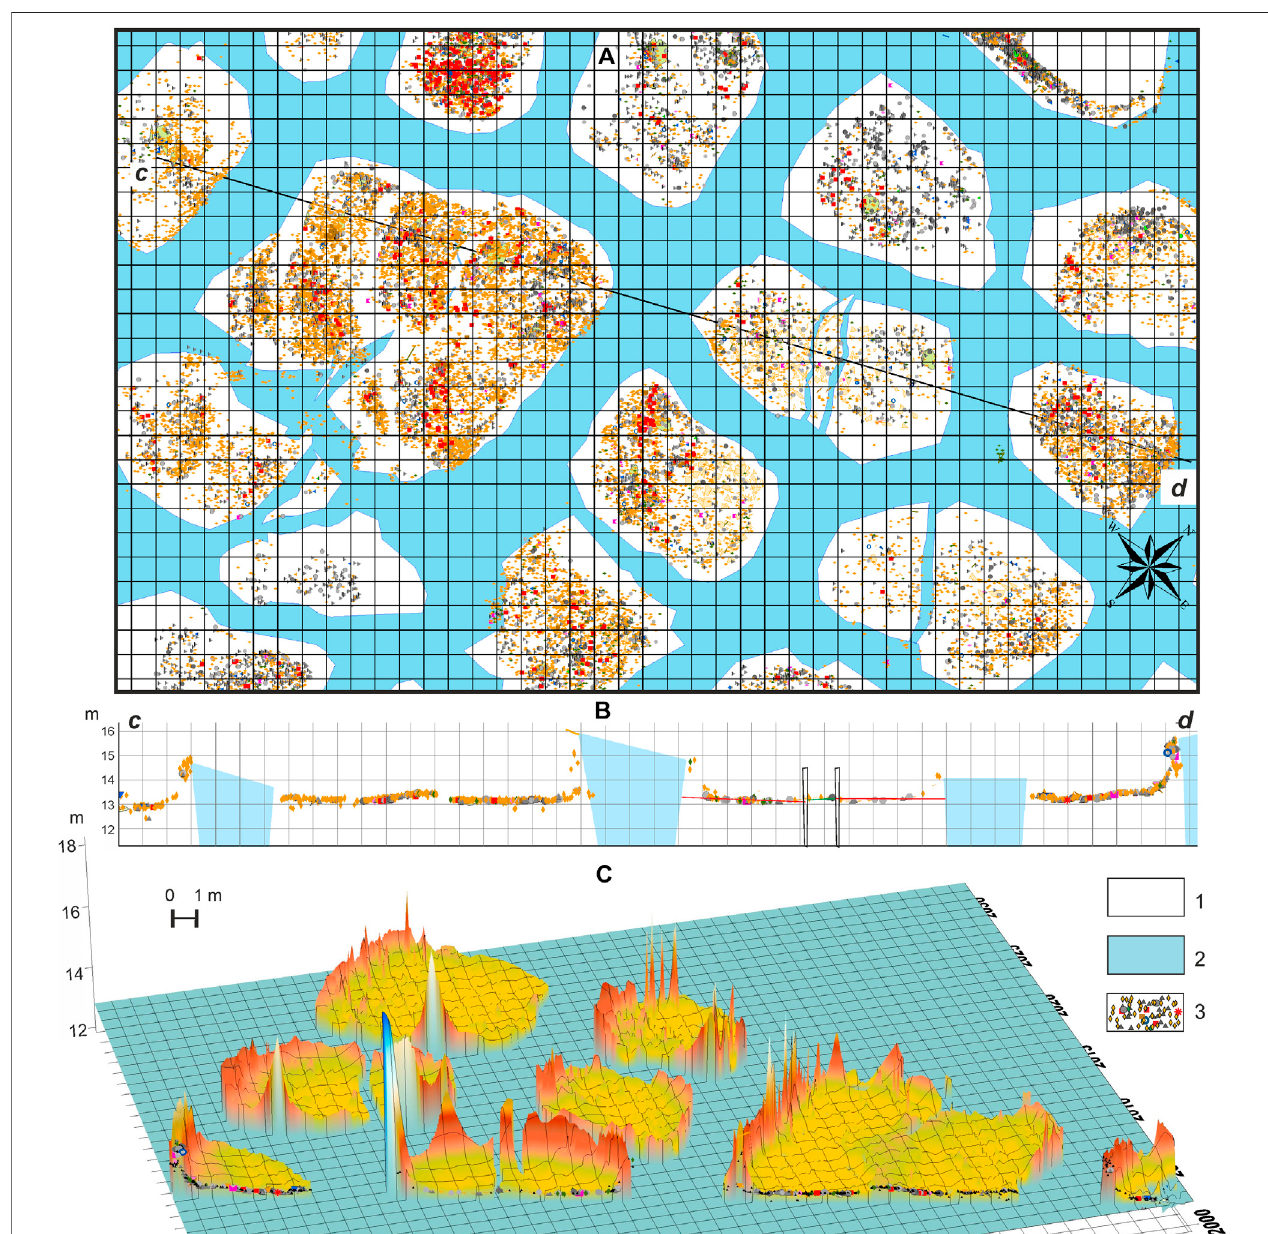
FIGURE 8 | Spatial distribution of in situ mapped cultural material of the Northern Point locality: (A) – excavation map; (B) - hypsometric pro fi le along line along line c – d shown in part (A) within 13 – 16 m elevation in absolute marks viewed from South; (C) - spatial distribution chart for archaeological material along line c – d shown in part (A) viewed from North. Illustration key: 1 — polygon ground body deposits; 2 — ice wedge; 3 — cultural material. After Pitulko and Pavlova (2016).